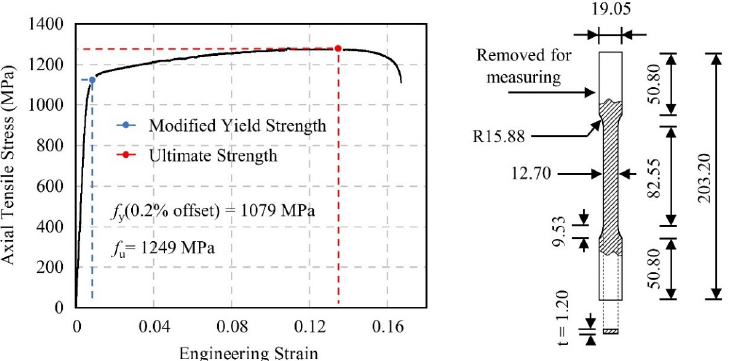
Figure 1. Constitutive model and test coupon [48].